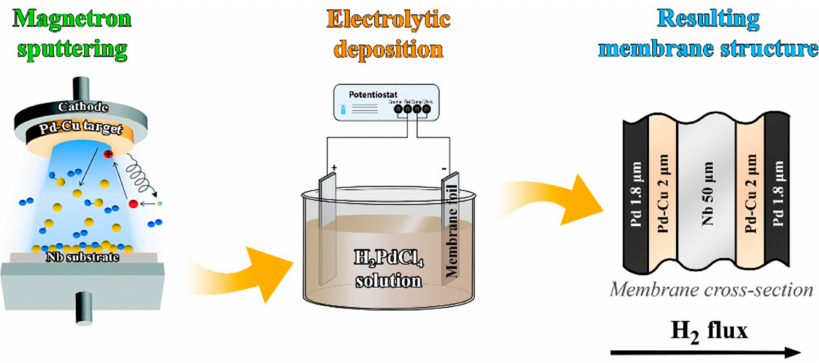
Figure 7. Stages of PdCu–Nb–PdCu membrane